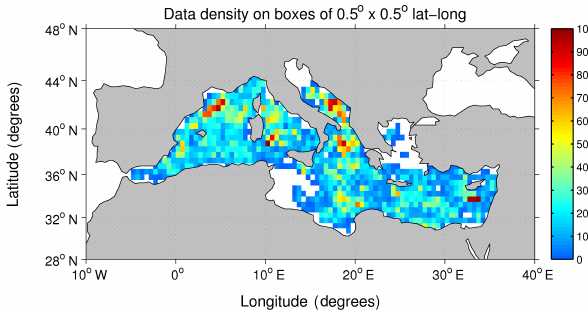
Figure 1. Number of Argo profiles on boxes of 0.5 ◦ × 0.5 ◦ of latitude–longitude, performed between 2003 and 2015 in the Mediterranean Sea and used to compute Argo DHs. Only profiles with a position quality flag of 1 (good data) have been